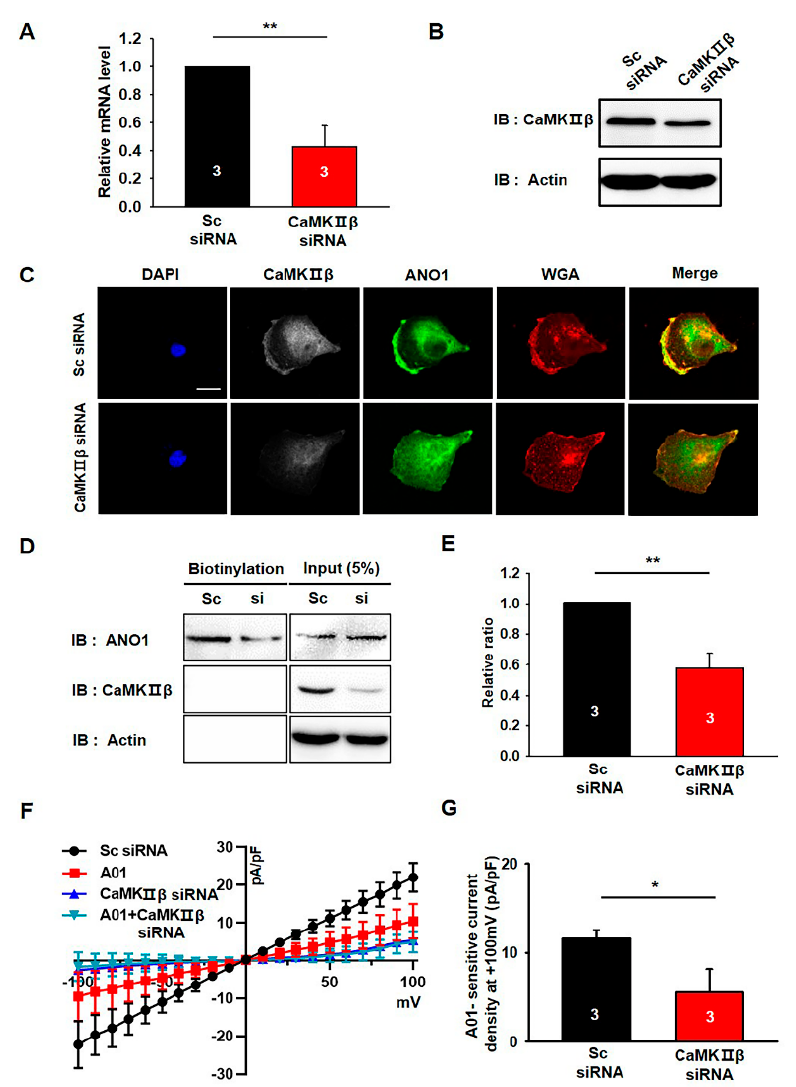
Figure 4. CaMKII β knockdown reduces the surface expression of ANO1 in U251 cells. ( A,B ) Validation of the silencing e ffi ciency of the siRNA against CaMKII β using qPCR and Western blotting. ( C ) U251 cells transfected with Sc shRNA or CaMKII β siRNA were imaged using antibodies against ANO1 and WGA. Nuclei were stained using DAPI staining solution. Scale bar, 20 µ m. ( D ) Cell surface biotinylation results from U251 cells transfected with Sc shRNA or CaMKII β siRNA. ( E ) The summary bar graph shows the summary of ( D ), data obtained from three independent experiments. ( F ) Averaged traces of whole-cell currents of U251 cells transfected with Sc shRNA, CaMKII β siRNA, or T16Ainh-A01 (A01). ( G ) The summary bar graph shows the inhibitory e ff ect of CaMKII β siRNA on ANO1–mediated current amplitude at ±100 mV. The bar graph shows normalized A01-sensitive current densities at + 100 mV. Number on each bar indicates n for each condition. All values are mean ± s.e.m. P -values were obtained with Student’s t-test. * P < 0.05 and ** P < 0.01.